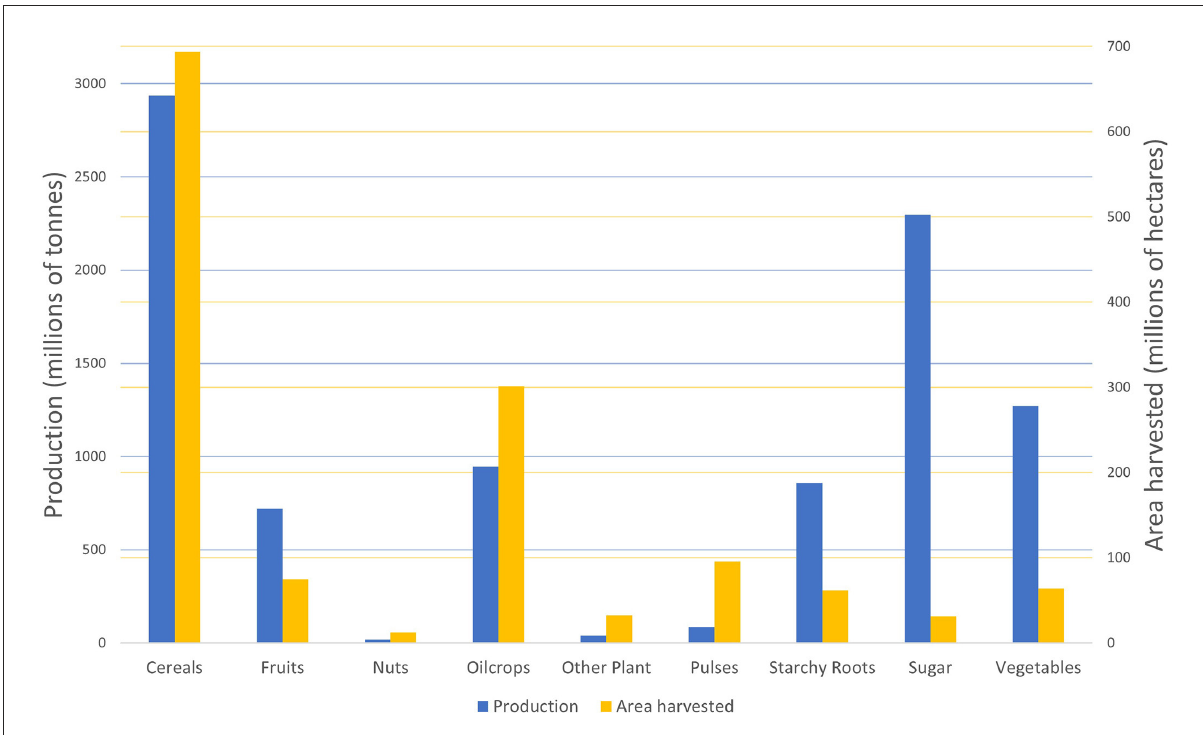
FIGURE2 2018 crop production and cropland area harvested by major crop group (FAO, 2021).